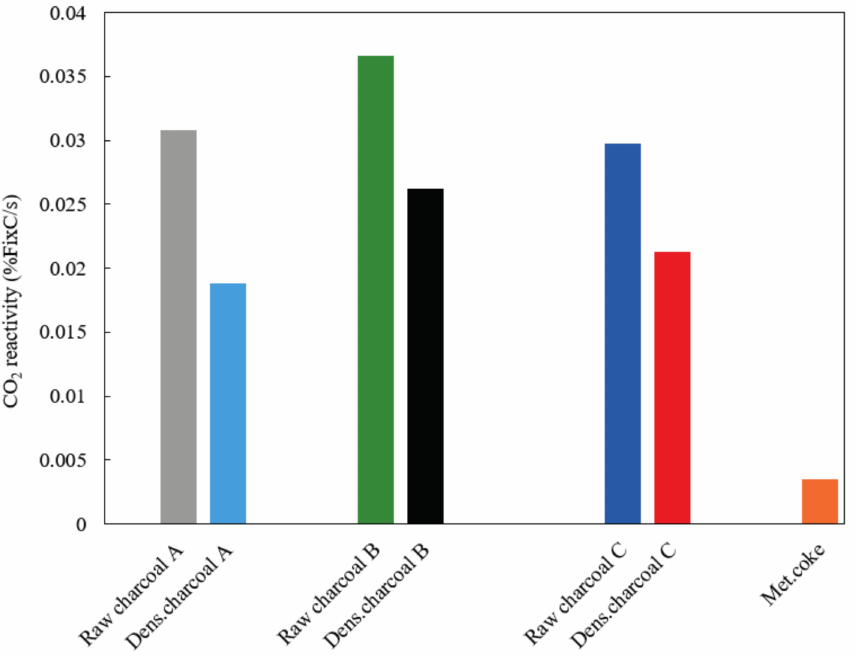
Figure 5. Summary of CO 2 reactivity at 1070 ◦ C of raw and densified charcoals and metallurgi- cal coke.